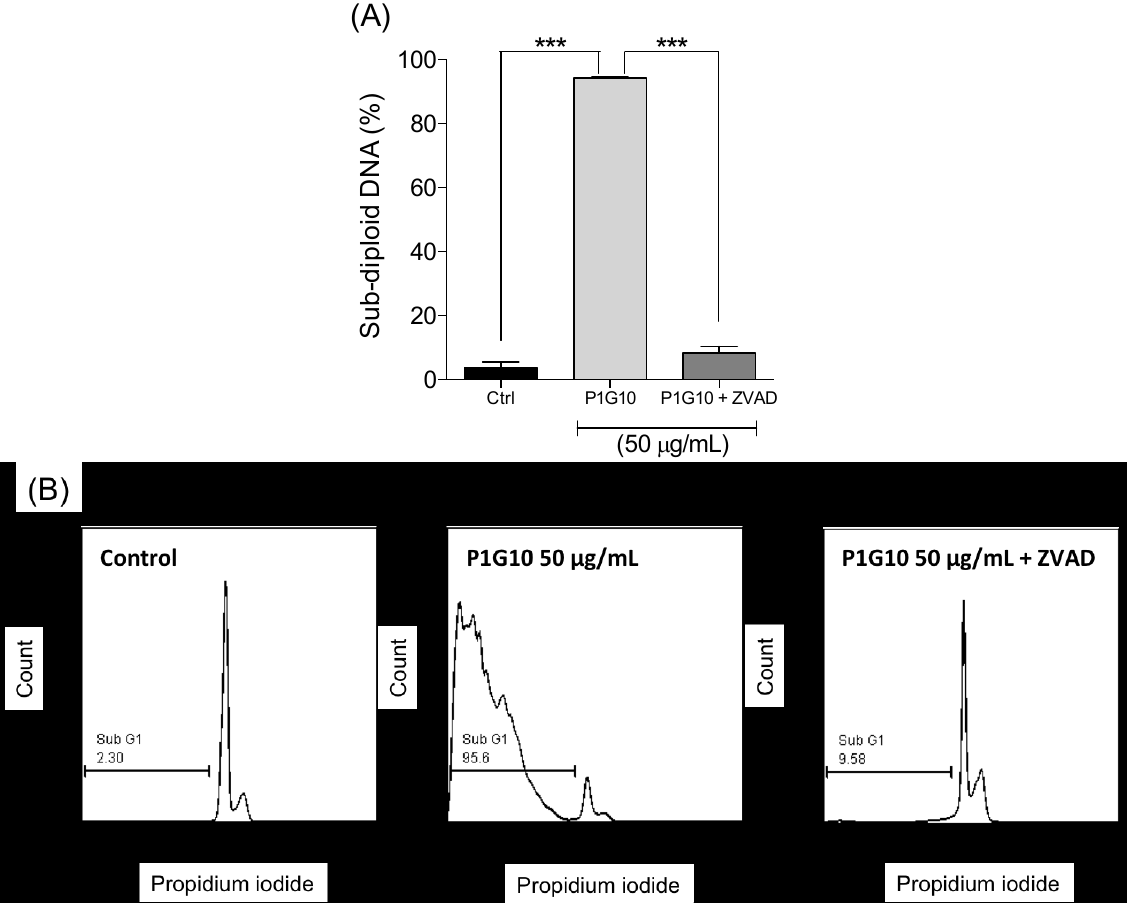
Figure 5. Caspase involvement in cell death. ( A ) B16F1 cells were pre-incubated with 40 μM ZVAD-FMK 40 min before treatment with 50 μg/mL P1G10 for 24 h.